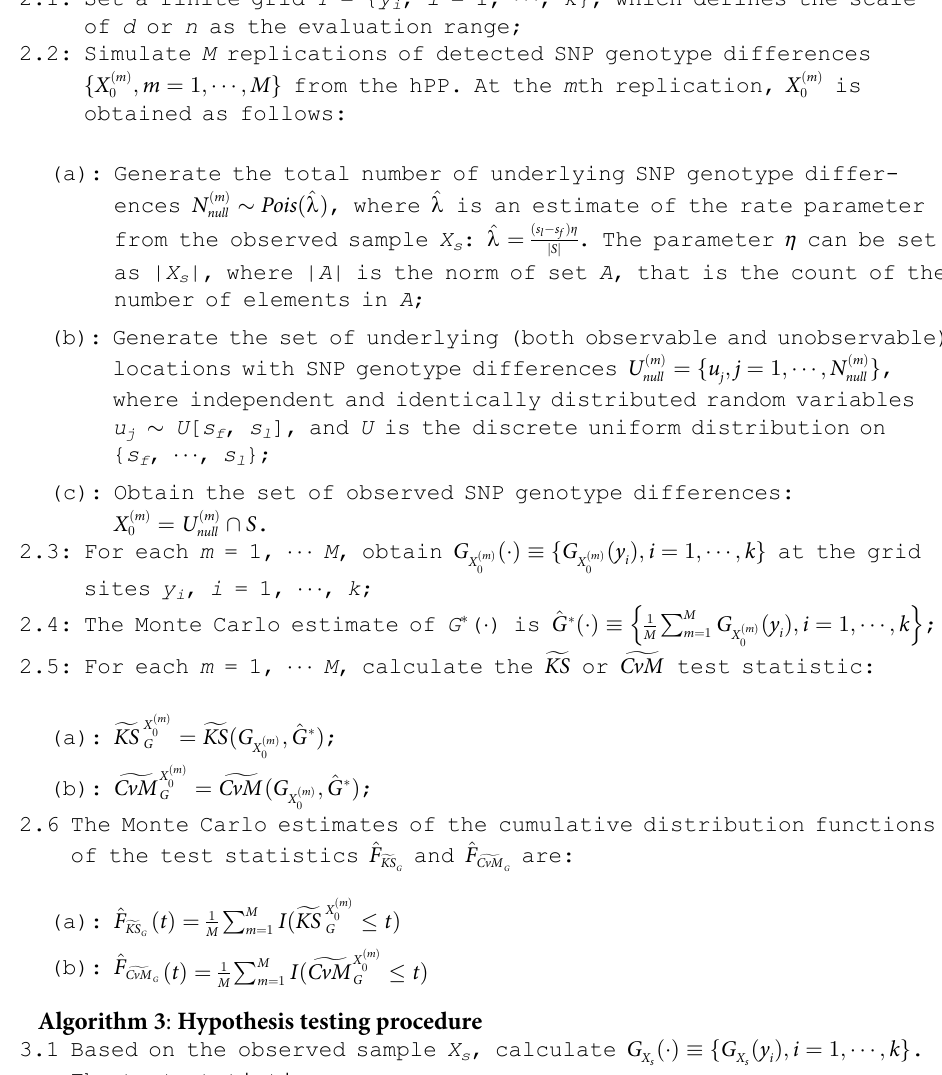
Algorithm 3 : Hypothesis testing